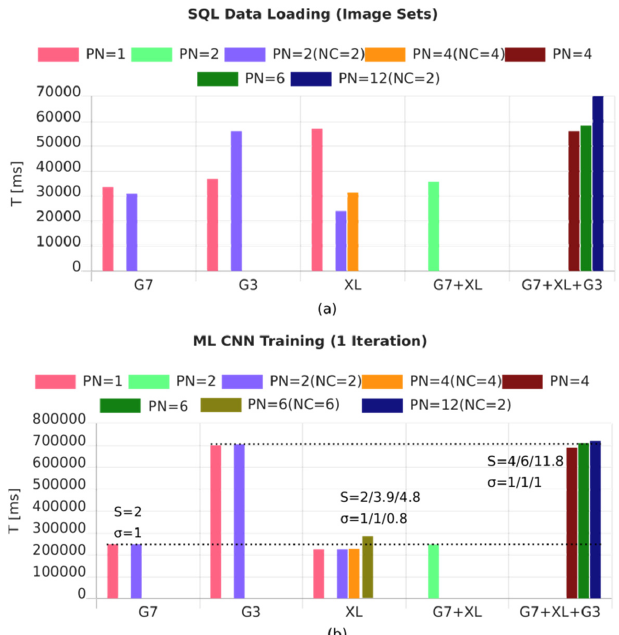
Figure 17. Results of the total computation times, with a distributed-parallel cluster with web workers, processed on smartphones and performing multi-model CNN-ML training with different numbers of distributed and parallel workers: ( a ) SQL data loading times; ( b ) ML training times (1 iteration = 1 epoch).